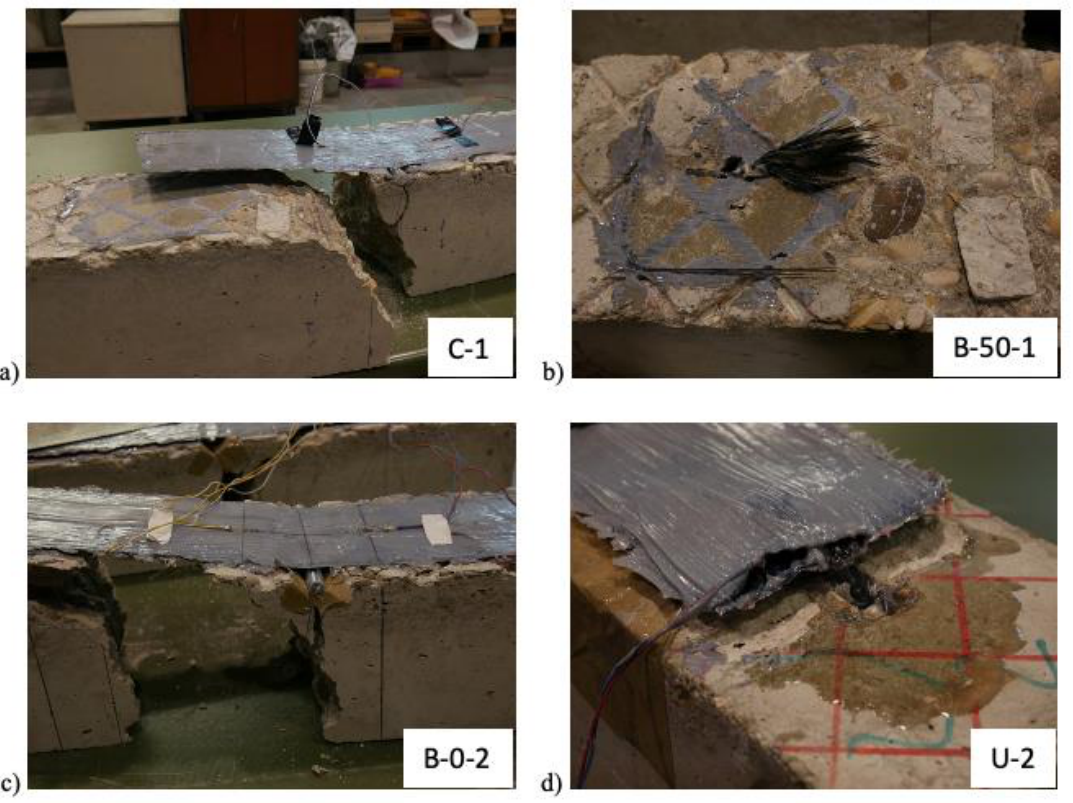
Figure 6. Observed failure modes: ( a ) Debonding; ( b ) Anchor rupture; ( c ) Concrete splitting; and ( d ) Anchor slippage.